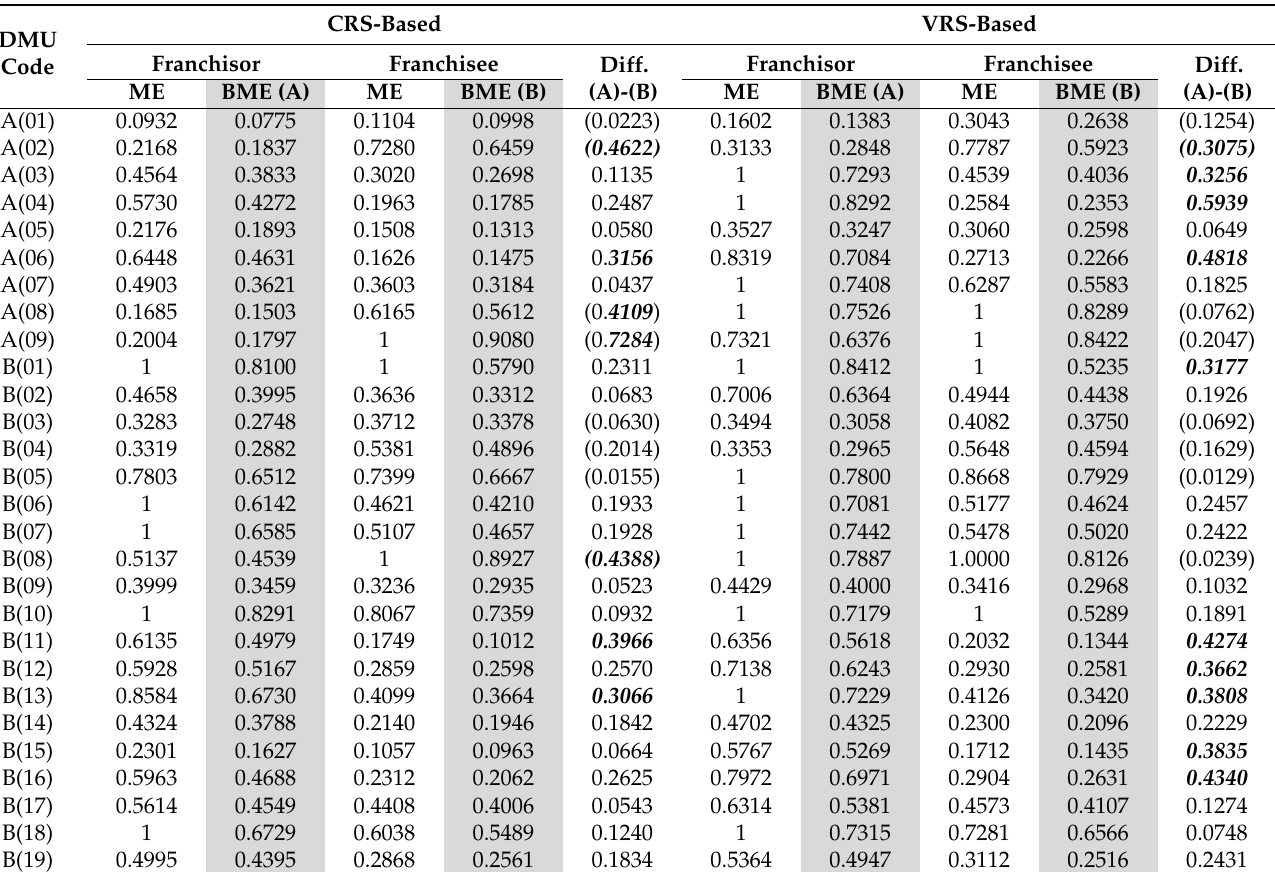
Table 5. Bootstrap meta efficiency analysis (based on CRS and VRS) and differences in bootstrap meta efficiency (BME) between franchisor and